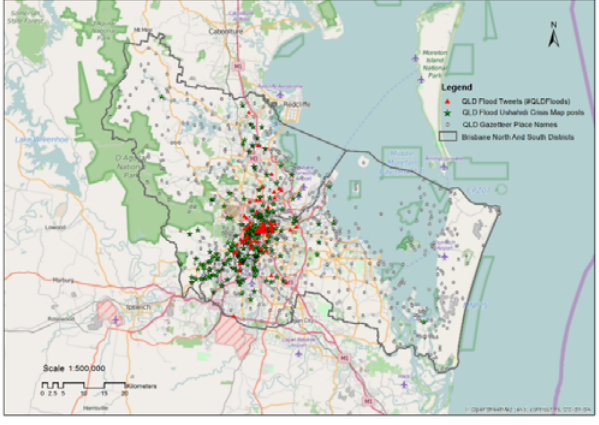
Figure 1. Study area and 2011 QLD Flood